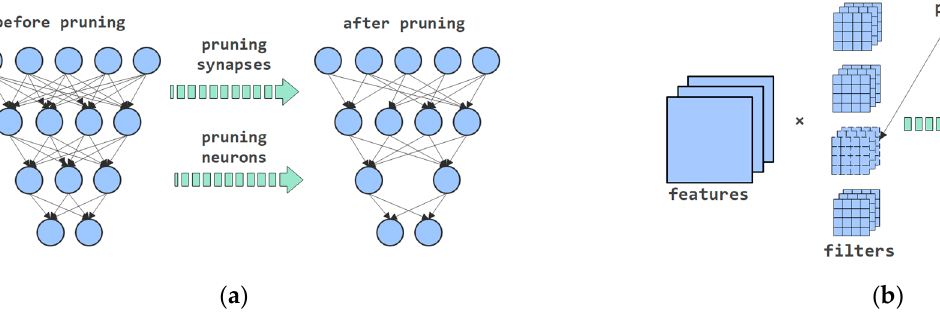
Figure 1. Illustration of unstructured pruning and structured pruning. ( a ) Unstructured pruning, where synapses—unimportant connections, can be pruned in order to sparse the network. Neurons can also be pruned to achieve the same purpose. ( b ) A typical structured pruning that prunes the filters. Channels of the generated feature maps are reduced accordingly.